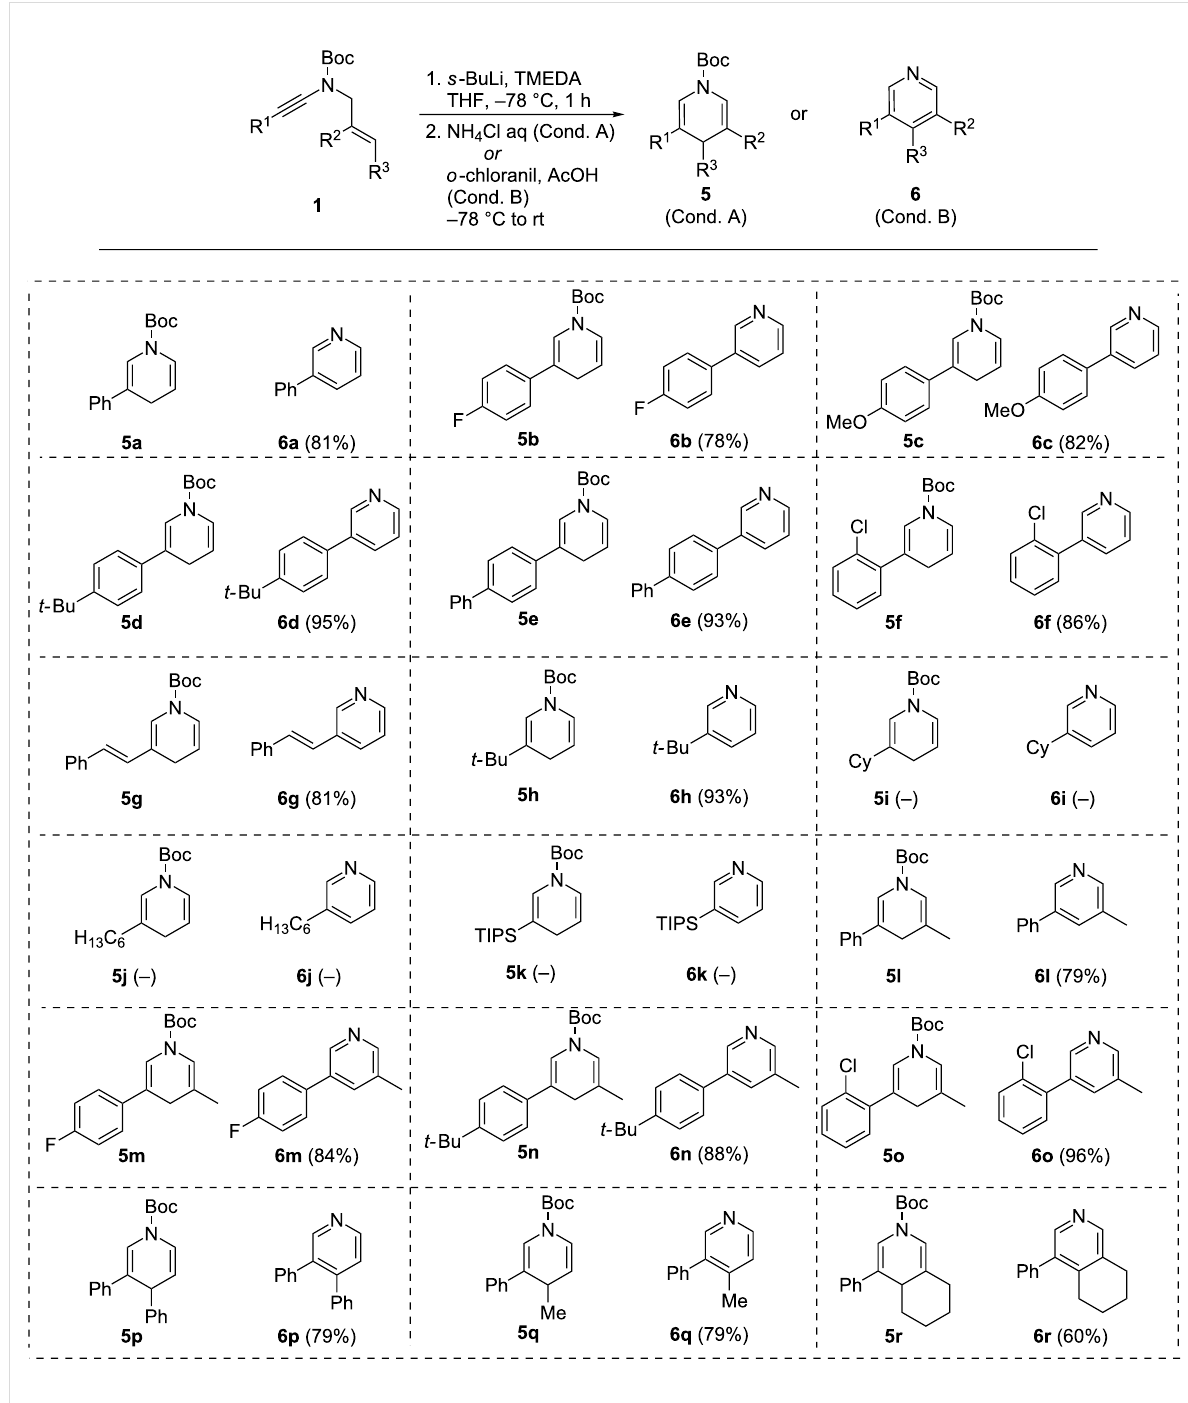
Scheme 4: Intramolecular carbolithiation of N -allyl-ynamides to 1,4-dihydropyridines and pyridines.